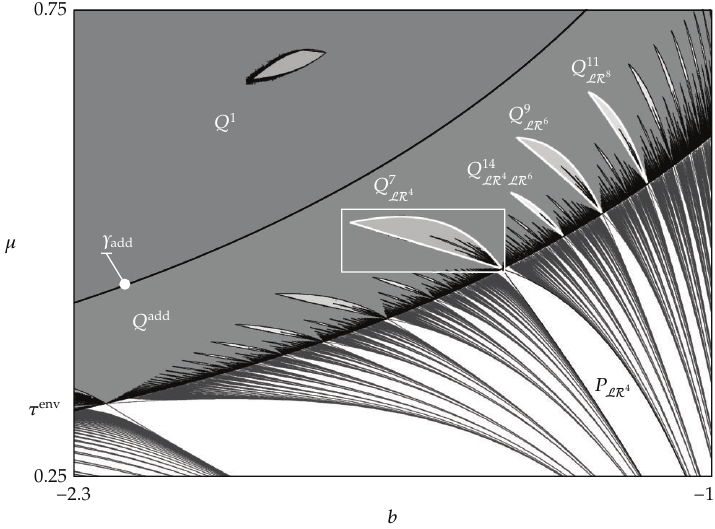
Figure 8: Numerically calculated bandcount diagram in the 2D parameter space for a (cid:6) 0 . 2, b (cid:6) − 2 . 3 ··· − 1 . 1, μ (cid:6) 0 . 25 ··· 0 . 75. Both the period adding (cid:7) gray lines (cid:8) and the bandcount-adding (cid:7) gray areas (cid:8) scenarios can be seen, separated by the boundary curve τ env . The white curves inside the white box show the (cid:7) analytically calculated (cid:8) interior crisis curves η r η (cid:2) LR 4 and LR 4 , which are the boundaries of the bandcount- . The other white curves show the interior crises corresponding to the respective labels. adding region Q 7 LR 4 The band-merging crisis curve γ add separates Q add from Q 1 . Note that the region in the upper part is an irregular region inside Q 1 . The marked rectangle is shown enlarged in Figure